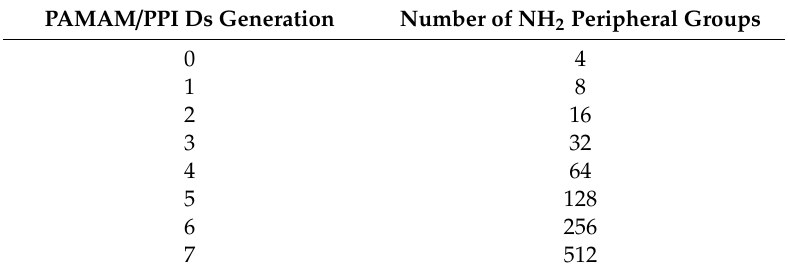
Figure 3. CADs developed in recent decades. Table 4. Two-increase of primary peripheral amine groups subsequent to the increase of one